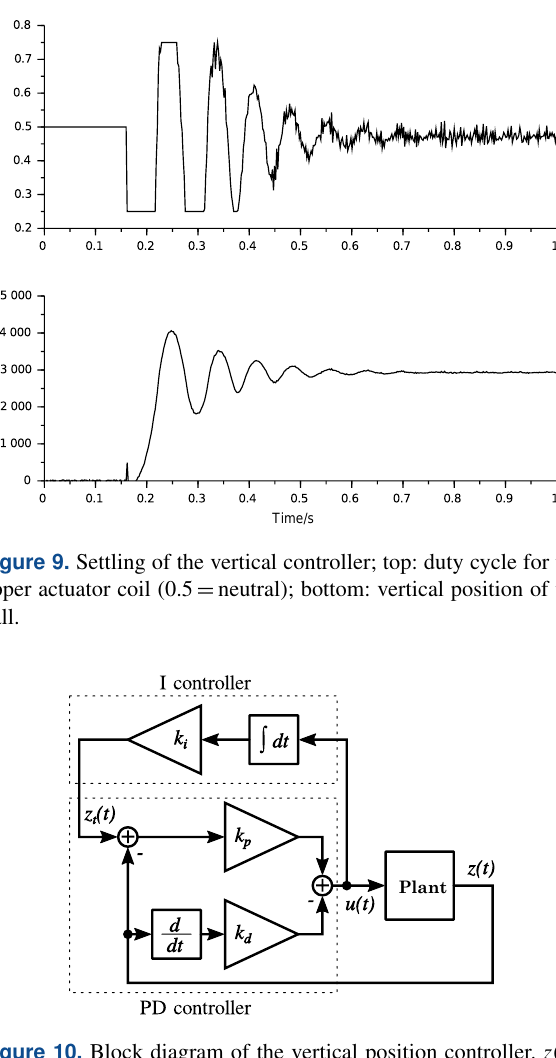
Figure 10. Block diagram of the vertical position controller. z ( t ): vertical position; z t ( t ): targeted position; u ( t ): actuating variable.